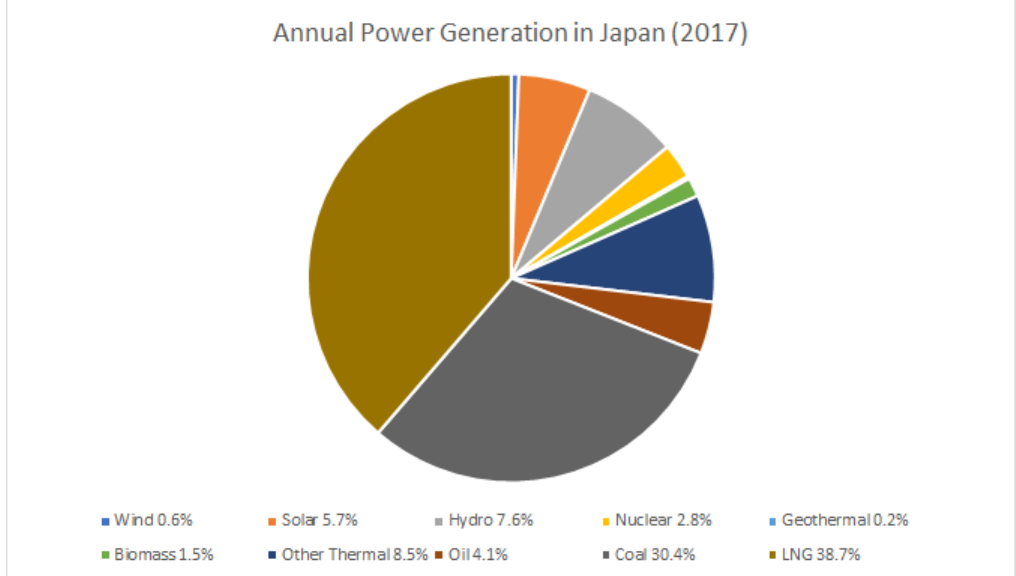
Figure 1. Electricity Generation by Fuel in Japan in 2017 (Created based upon data from METI (2018)